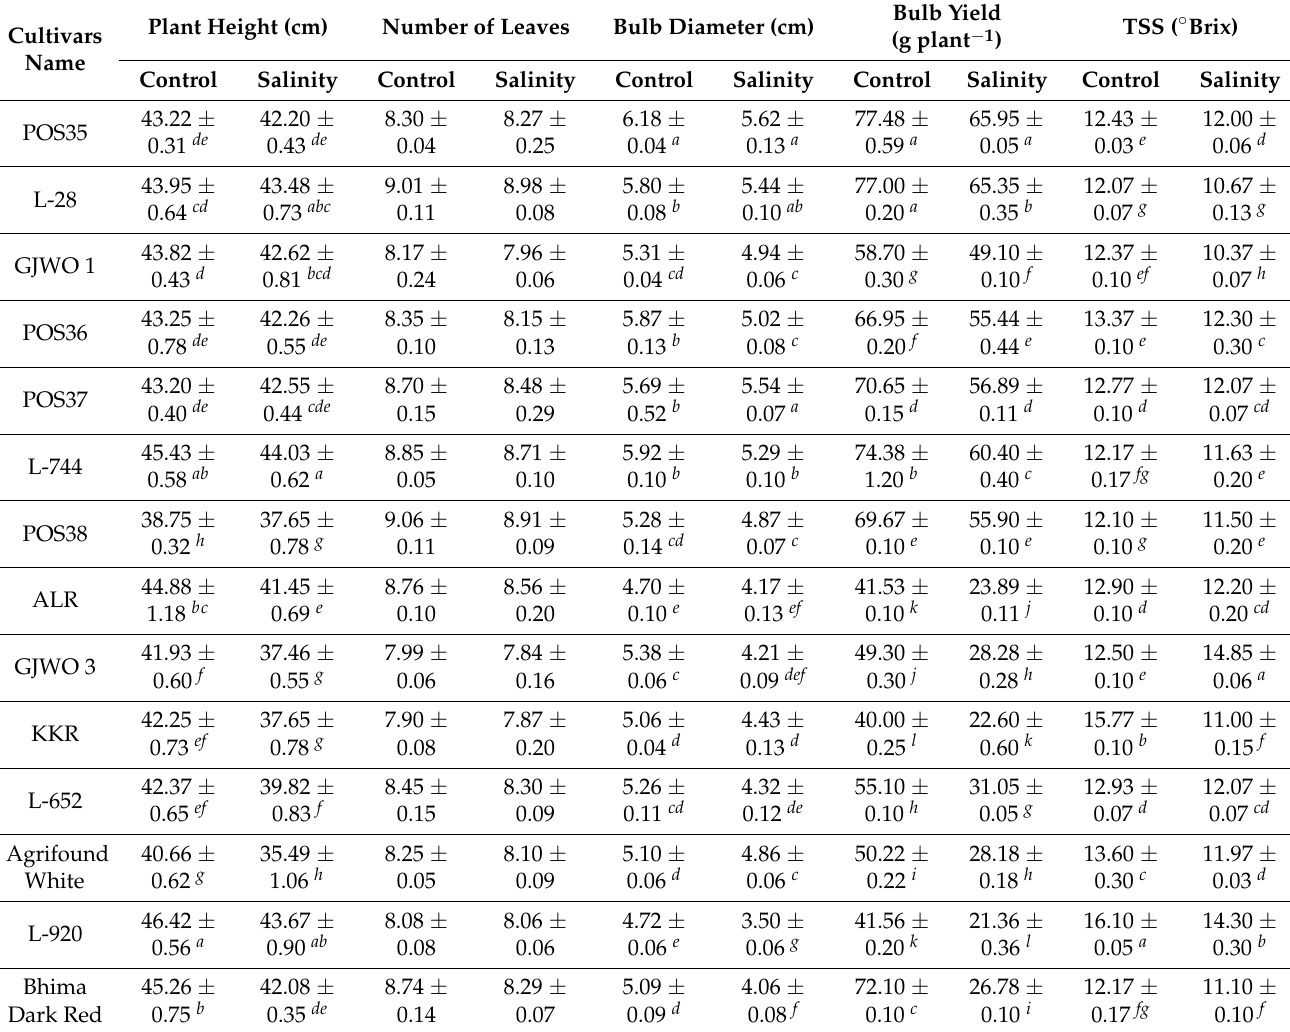
Table 5. Means comparisons of morphological traits of selected onion accessions under control and salinity stress.